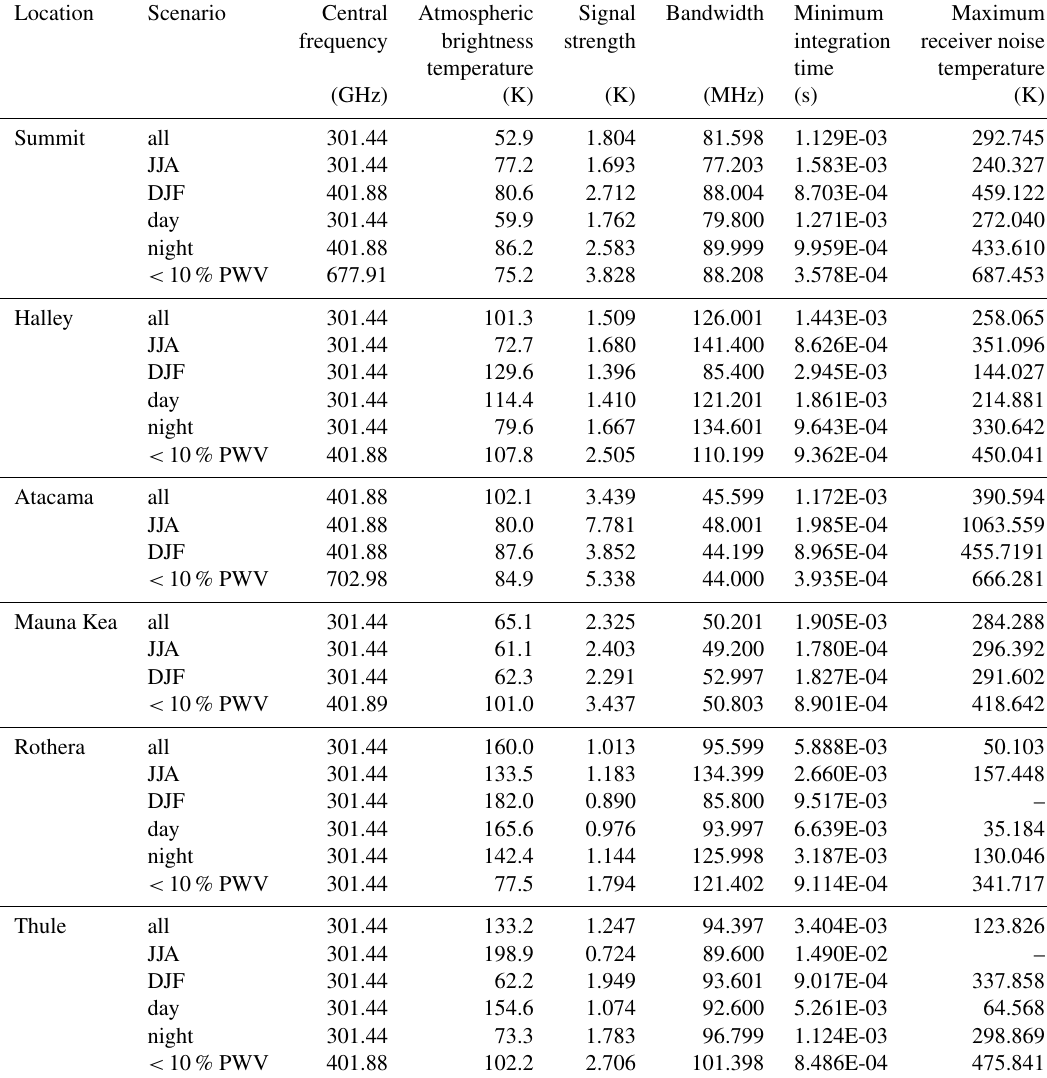
Table 8. As Table 5 but for N 2 O.